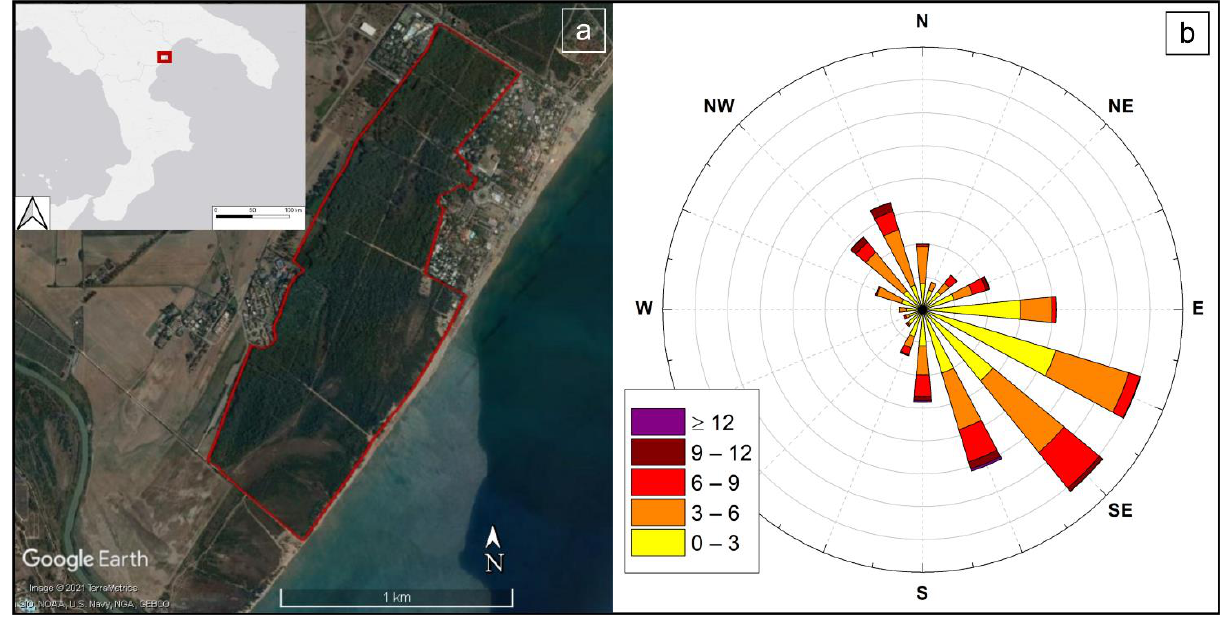
Figure 1. ( a ) Study area location and boundaries of the southern part of the Metaponto Natural Reserve where we conducted a sampling transect (image source: Google Earth) and ( b ) a wind rose showing the prevailing winds in the study area (average from January – August 2019). Meteorological data were provided by Protezione Civile of the Basilicata Region.